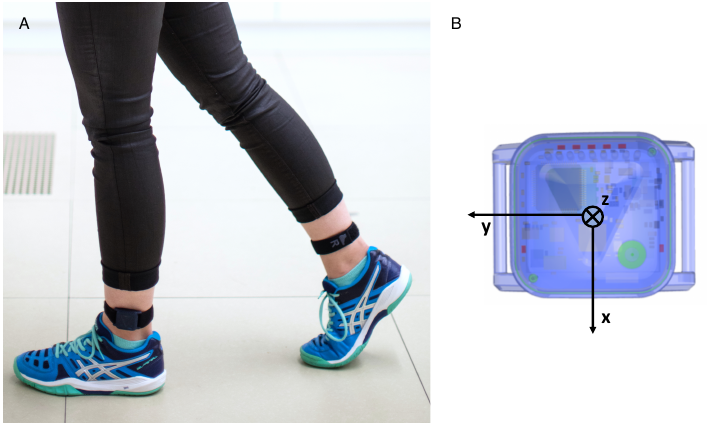
Figure 1. Subject wearing sensor modules attached laterally above each ankle ( A ). Schematics of the sensor module with its coordinate system ( B